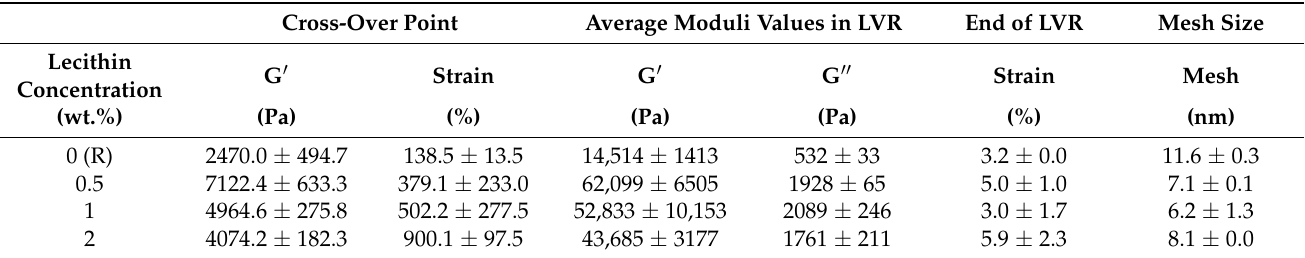
Table 8. Values for chemically crosslinked PVA-chitosan hydrogels after drying and rehydration obtained from strain and frequency sweep